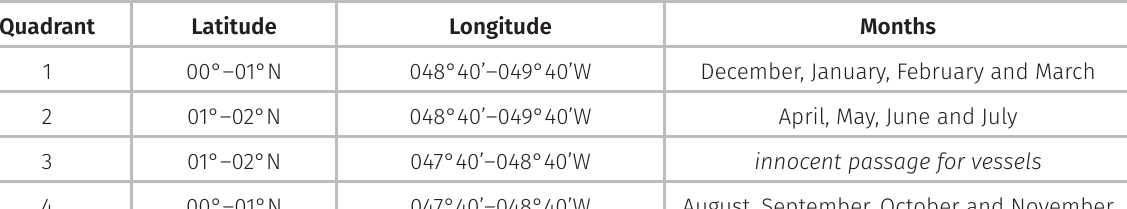
Table III. Geographic coordinates of quadrants in the RPA zoning proposal, off the north coast of Brazil. Quadrant